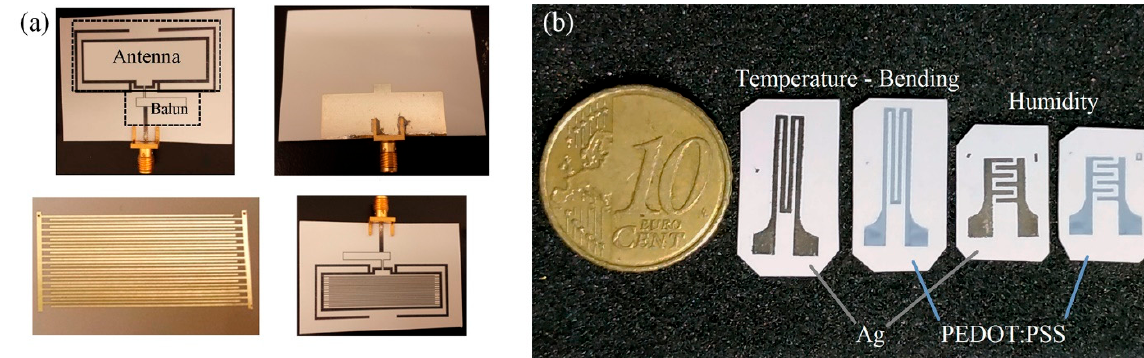
Figure 8. ( a ) Paper-based resistive humidity sensors: exploitation of substrate resistivity variations via antenna detuning for a passive RFID sensor node (reproduced with permission from [12] copyright 2016, MDPI AG); ( b ) PEDOT:PSS and Ag NP paper-based resistive humidity device on paper (reproduced with permission from [17] copyright 2020, Elsevier).